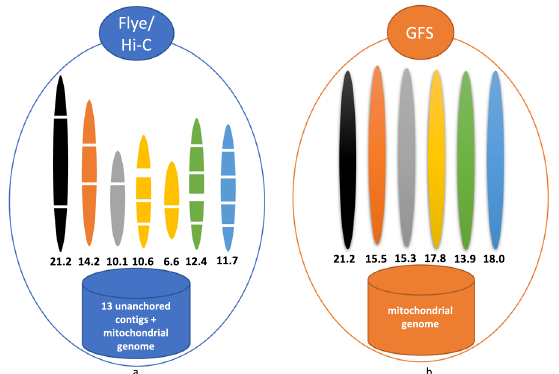
Fig. 3 | Comparison of Flye assemblywithHi-C scaffolding and GALAassembly oflongreadsofthe C.elegans genome.a TheFlyeassemblywithHi-Cscaffolding contains numerous gaps and 13 unanchored contigs in the assembly. b GALA produces gap-free assembly for each chromosome. Note this is not a fair com- parison since GALA did not use Hi-C data in this assembly.